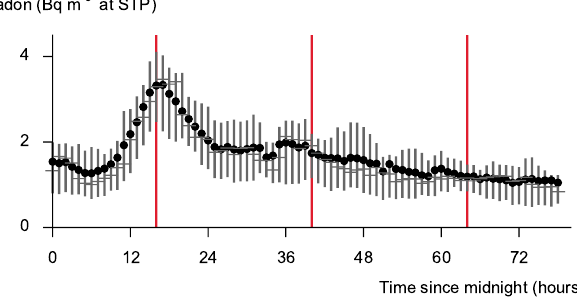
Figure 7. The 3-day radon composites ( ∼ 19 samples per bin) of one anabatic day followed by two non-anabatic days, selecting north-west fetch. Red lines show the median peak radon concentra- tion, 24h after, and 48h after. The symbols have the same meaning as in Fig. 4.